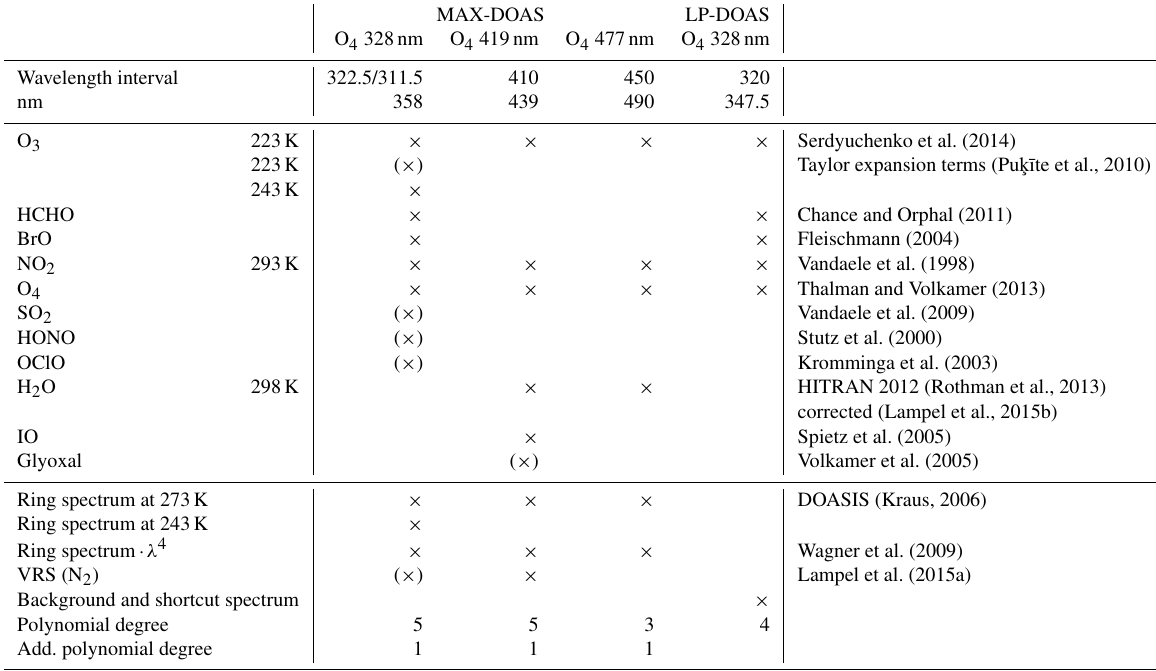
Table 1. Retrieval wavelength intervals for DOAS measurements. Values in parentheses were used for sensitivity studies